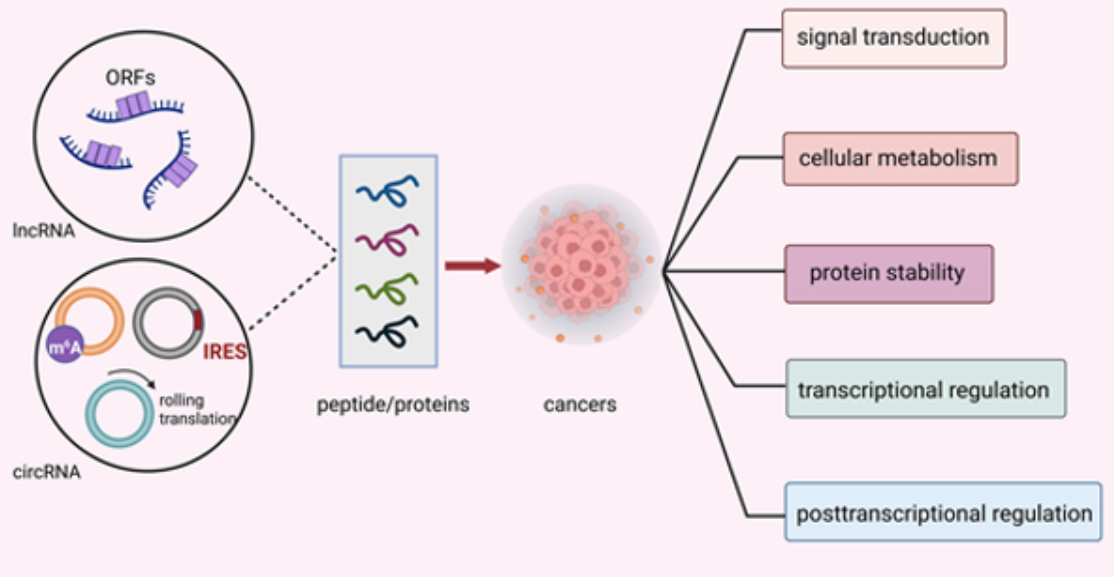
Figure 1. Translation mechanisms of ncRNA ‐ encoded peptides/proteins. Peptides/proteins encoded by ncRNAs exhibited their effect through modulating signal transduction, cellular metabolism, protein stability, transcriptional and post ‐ transcriptional activity in cancers.